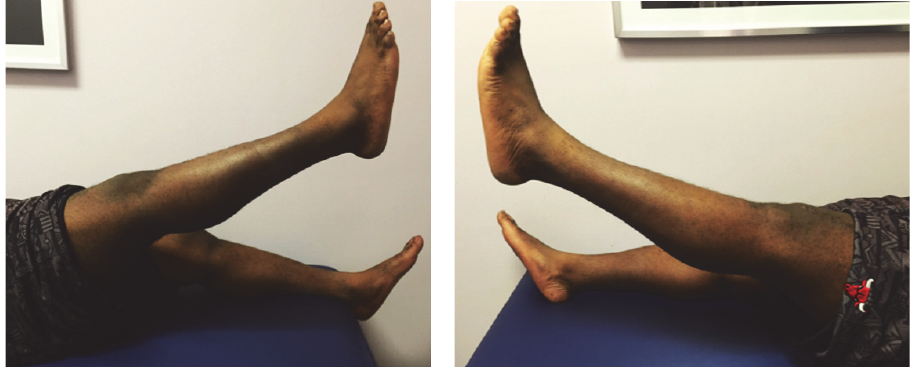
Figure 2: Clinical photos showing full active extension 2 years postoperatively without extension